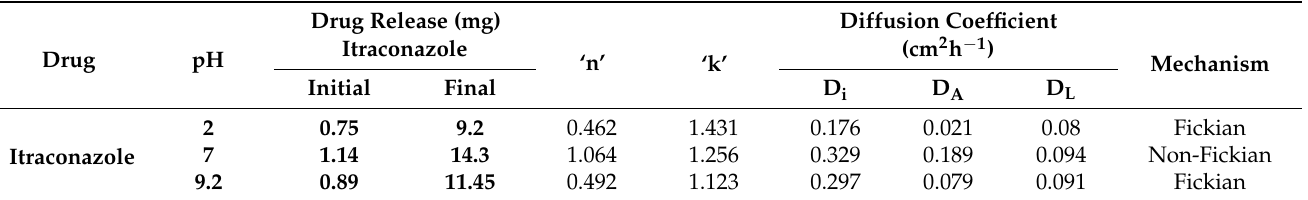
Figure 7. Effect of pH on release of itraconazole from CH-Ag bionanocomposite at different time intervals. Table 3. Diffusion exponent ‘n’, gel characteristic constant ‘k’and diffusion coefficient of itraconazole drug release through CH-Ag bionanocomposite at different